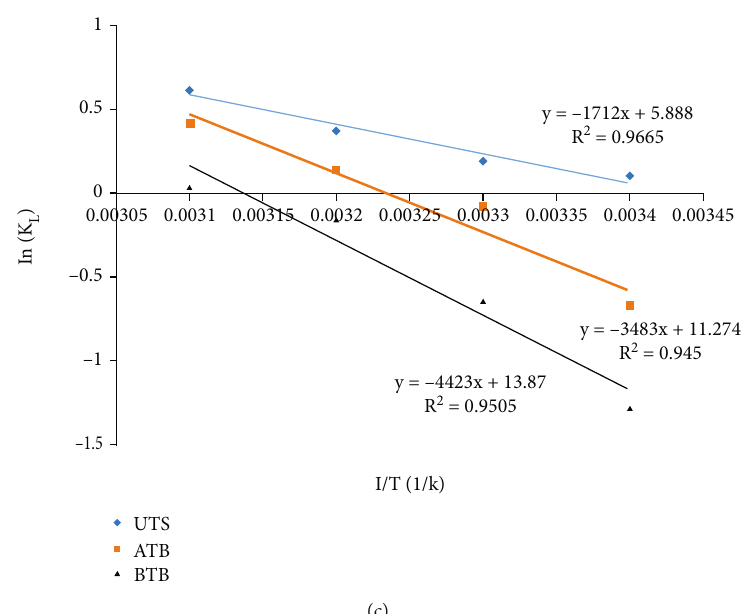
Figure 10: Plots of Cr (VI) adsorption onto Te ff straw biosorbent: (a) pseudo- fi rst order and (b) pseudo-second order and (c) Van ’ t Ho ff ’ s plot. Table 4: Thermodynamic parameters for adsorption of Cr (VI) onto Te ff straw biosorbent.